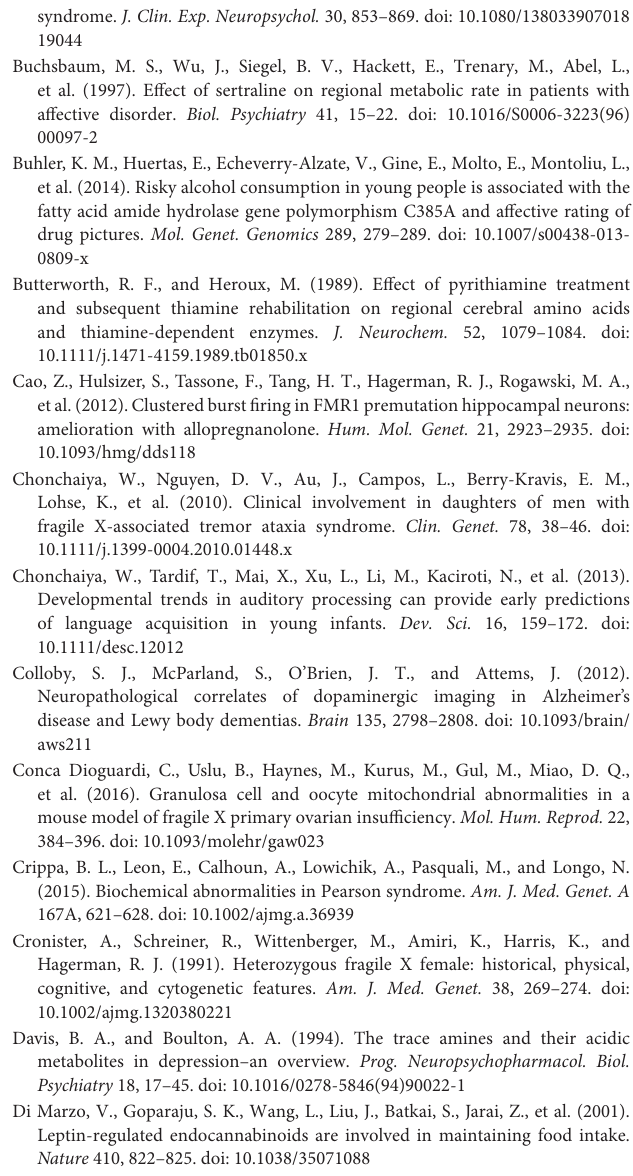
TABLE S1 | Complete list of metabolites identified by mass spectrometry. Metabolite identification was performed through the use of several databases including PubChem Compound, KEGG and HMDB, and the online chemical translation service, as described in the